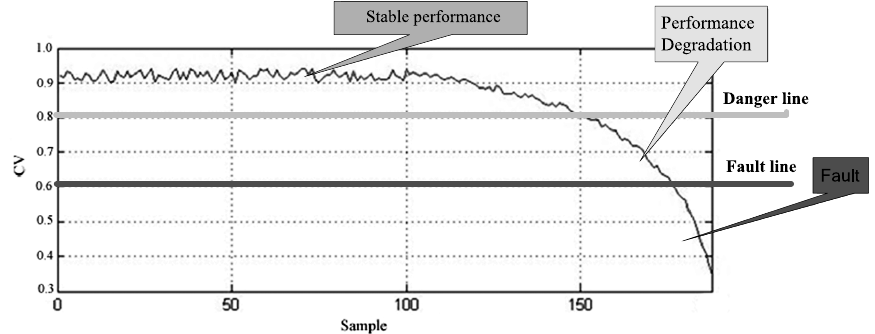
Fig. 3. Different performance degradation states during the life cycle.